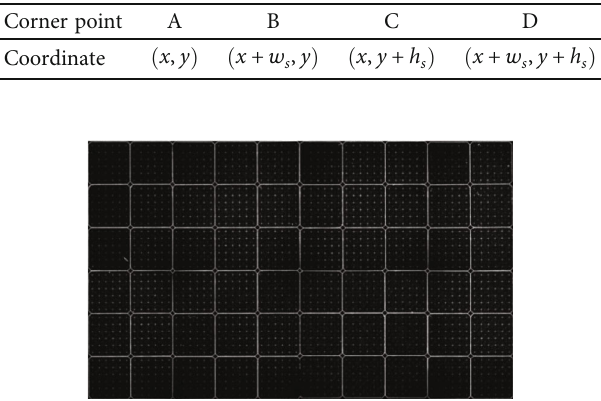
Figure 4: The edge binarization image of the silicon wafer region.